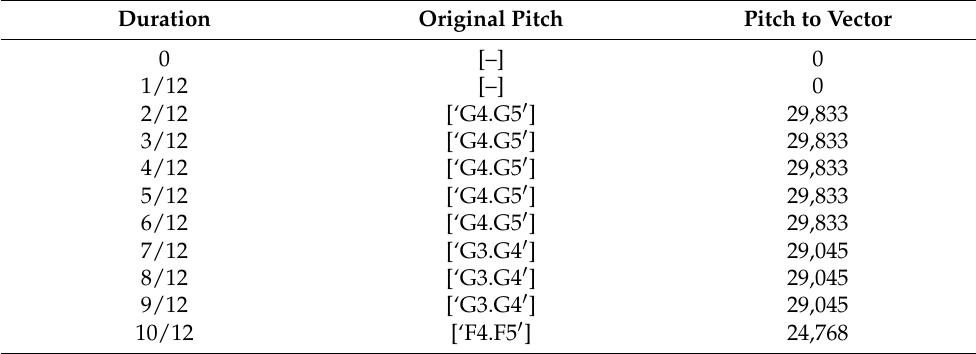
Table 6. The results of the Pitch2vec preprocessing. [–] denoted the rest of MIDI. [‘*.* . . . ’] denoted the set of MIDI